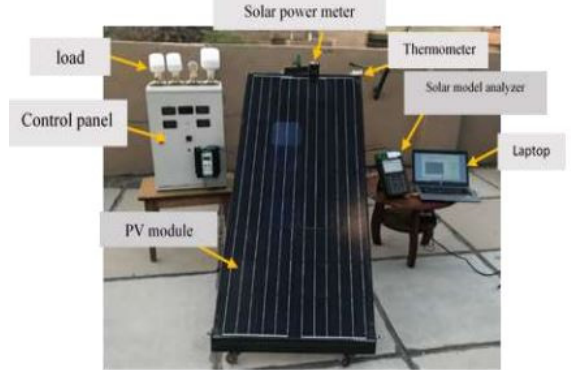
Figure 3. Experimental setup system with measuring device